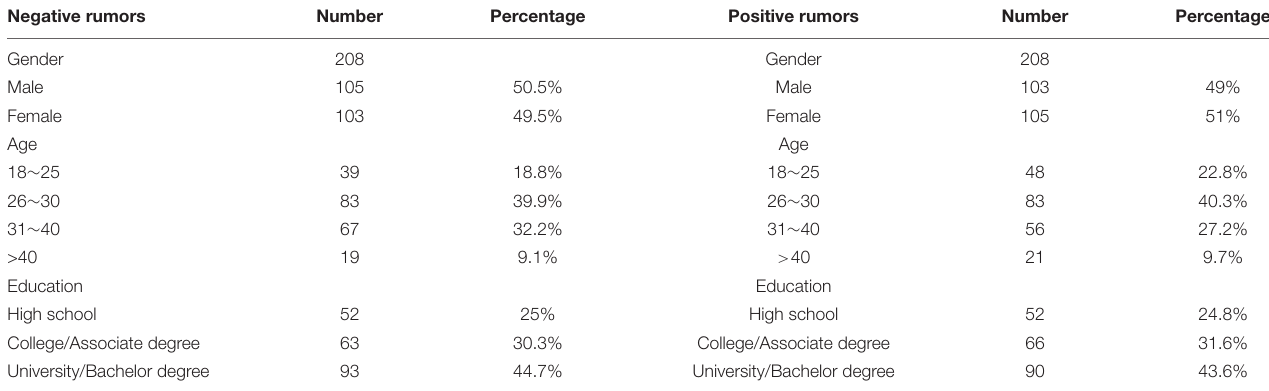
TABLE 1 | Demographic characteristics of the